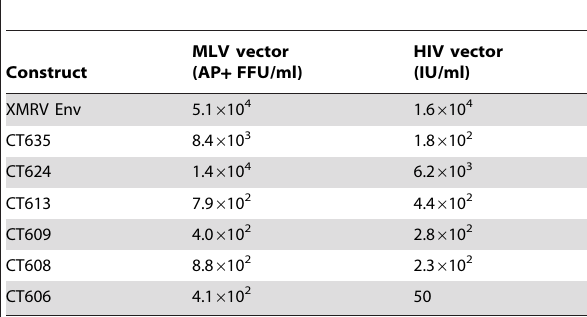
Table 2. Titers of MLV and HIV-1 vectors bearing XMRV Env and truncation